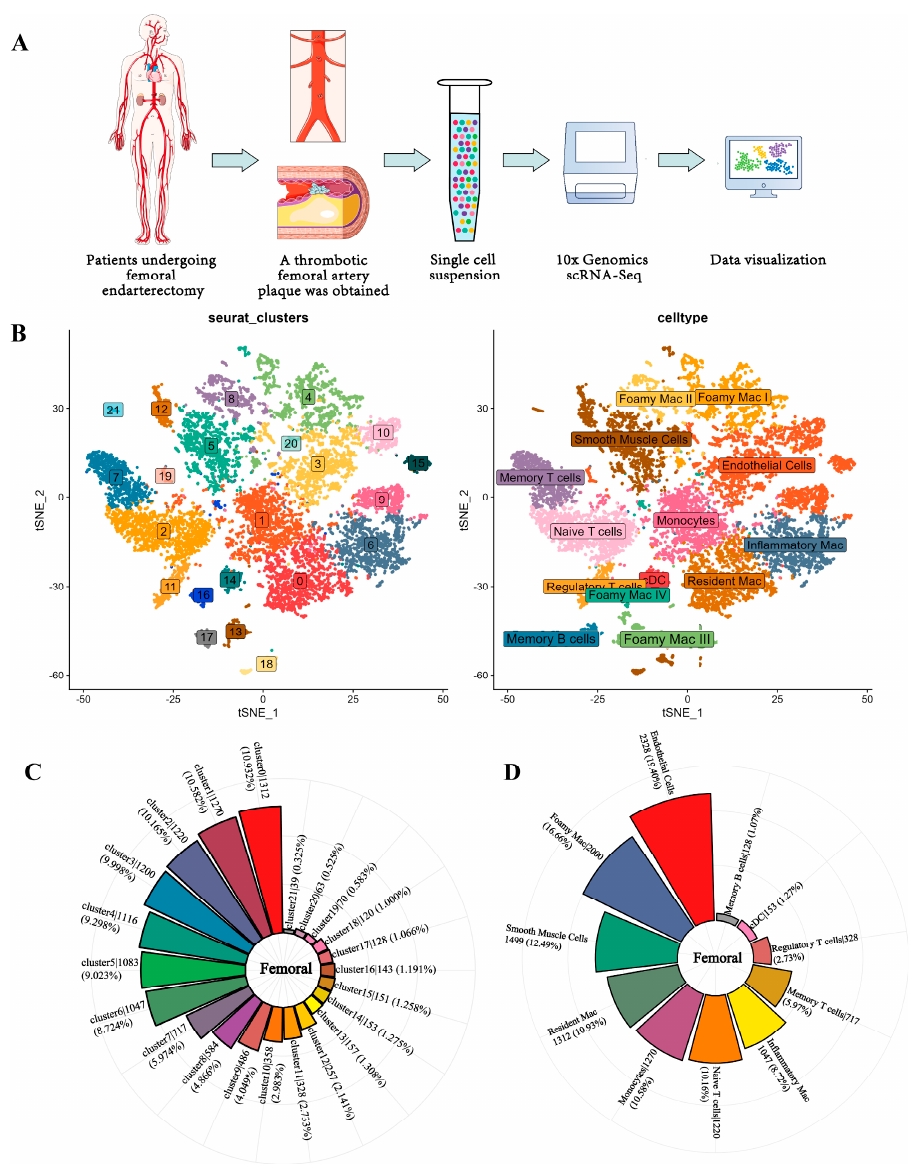
Figure 1. Procedures for sampling and analysis of femoral atherosclerotic plaques. ( A ). Femoral atherosclerotic plaques were obtained by femoral endarterectomy, and approximately 14,000 cells were extracted for subsequent analysis. ( B ). The tSNE projection cluster scatter diagram was noted with clusters and cell types. ( C ). The number and percentage of each clustered cell type based on T-distributed stochastic neighbor embedding (tSNE) projection are presented. ( D ). The pie chart shows the proportion of all cell types. Less to more in a clockwise direction.